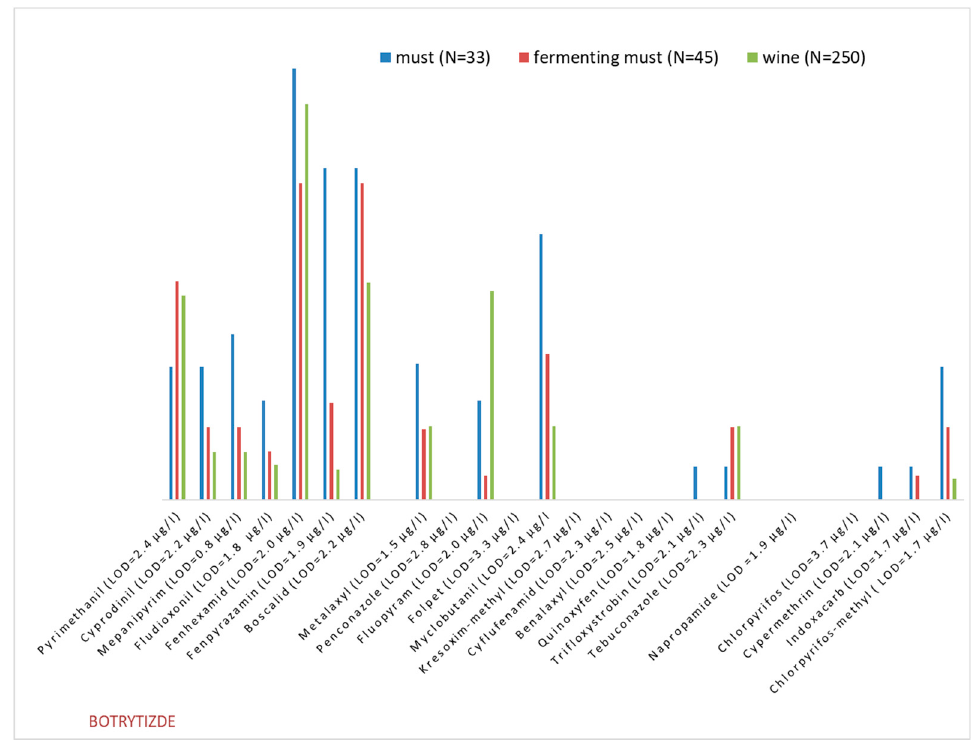
Figure 1. Percentage of samples with detectable concentrations of residues. For identification of the samples Tables S1 and S2.